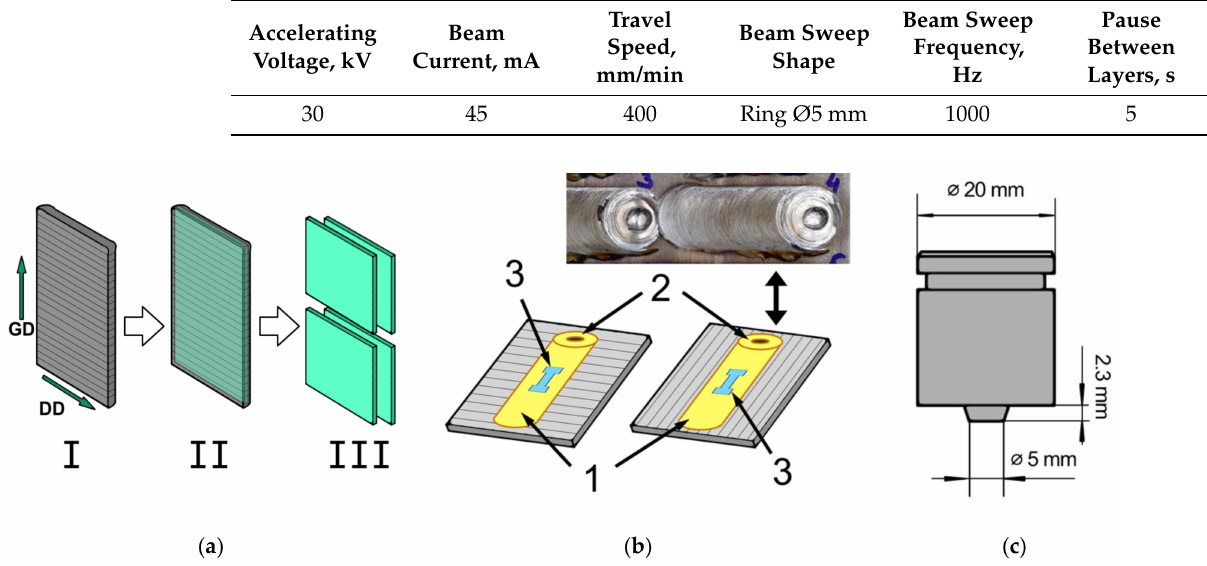
Table 1. 3D-printing parameters for Ti-6Al-4V wall.